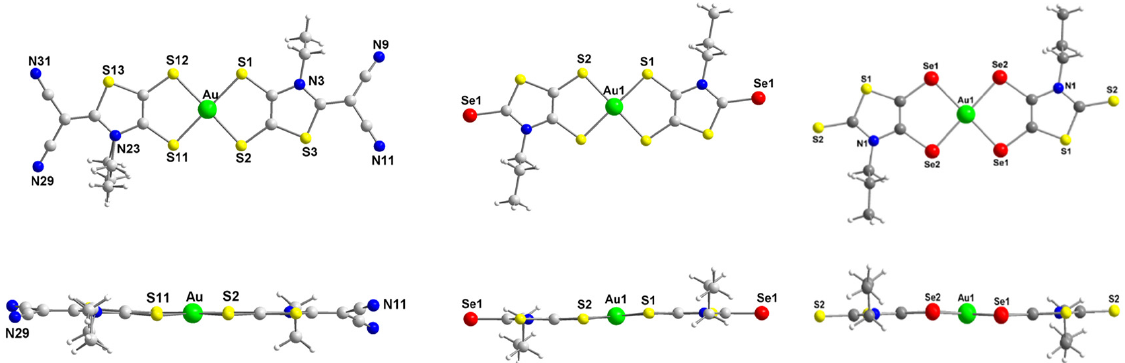
Figure 1. Molecular structures of monoanionic gold complexes, [AuSEt(=C(CN) 2 )] − 1 ( left ), [AuSPr(=Se)] − 1 ( middle ) and [AuSePr(=S)] − 1 ( right ).